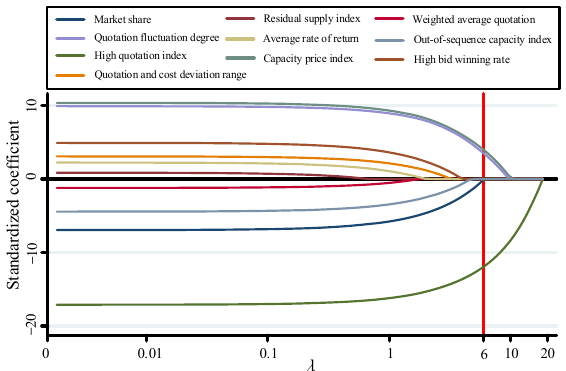
Figure 6. Effect diagram of change in indicators with the value of λ .